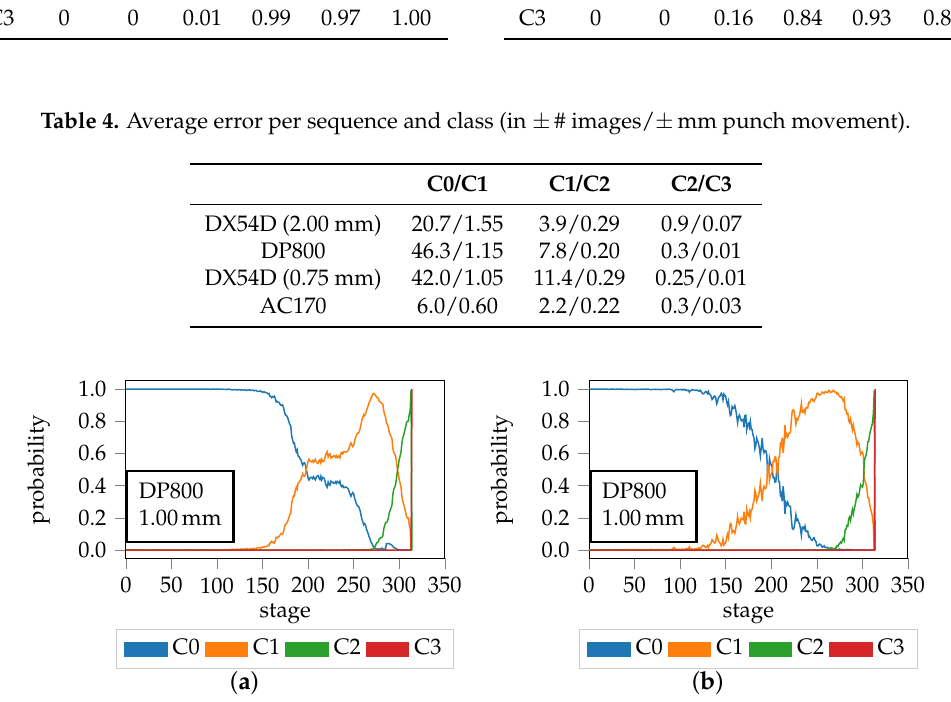
Figure 13. Probability progression over time of DP800-S060-2 of ( a ) PS 24 Homogeneity and ( b ) PS 24 HoG 180 10 ◦